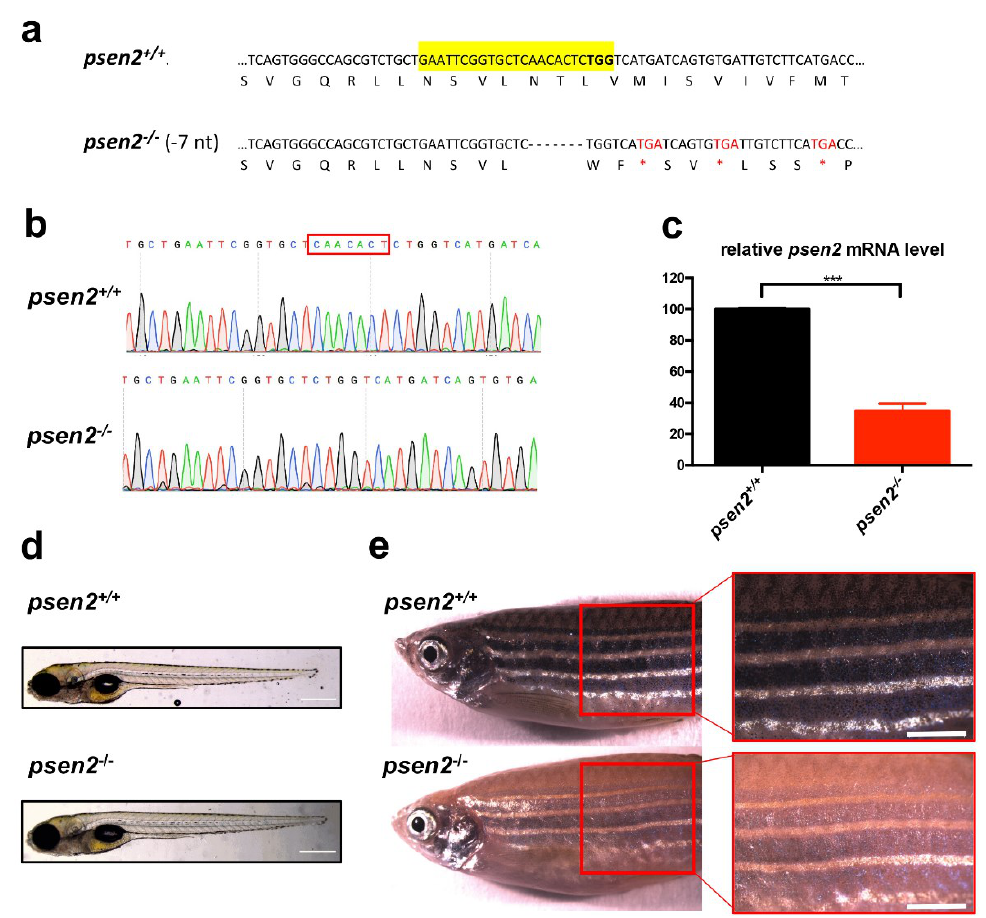
Figure 1. Knockout (KO) of psen2 gene. ( a ) Partial nucleotide and amino acid sequences of psen2 exon 4 showing a 7-bp deletion, confirmed by DNA sequencing. Deleted nucleotides are represented by dashes. CRISPR target site is highlighted in yellow and the protospacer-adjacent motif in bold. The 7-bp deletion results in a coding frameshift, with the insertion of premature stop codons (three in exon 4 marked in the figure as red asterisks, nine more in the following coding region). ( b ) Sequencing chromatographs of psen2 +/+ and psen2 – / – alleles. The red box delineates the area of the induced deletion. ( c ) RT-qPCR analysis on 1-year psen2 +/+ and psen2 – / – fish brain, showing a statisti- cally significant decrease in psen2 mRNA level in psen2 – / – mutants. Values represent the mean ± SEM. Data were generated from 3 biological replicates for each condition. Statistical significance was de- termined by two-tailed Student’s t-test (***, p < 0.001). ( d ) Representative images of psen2 +/+ and